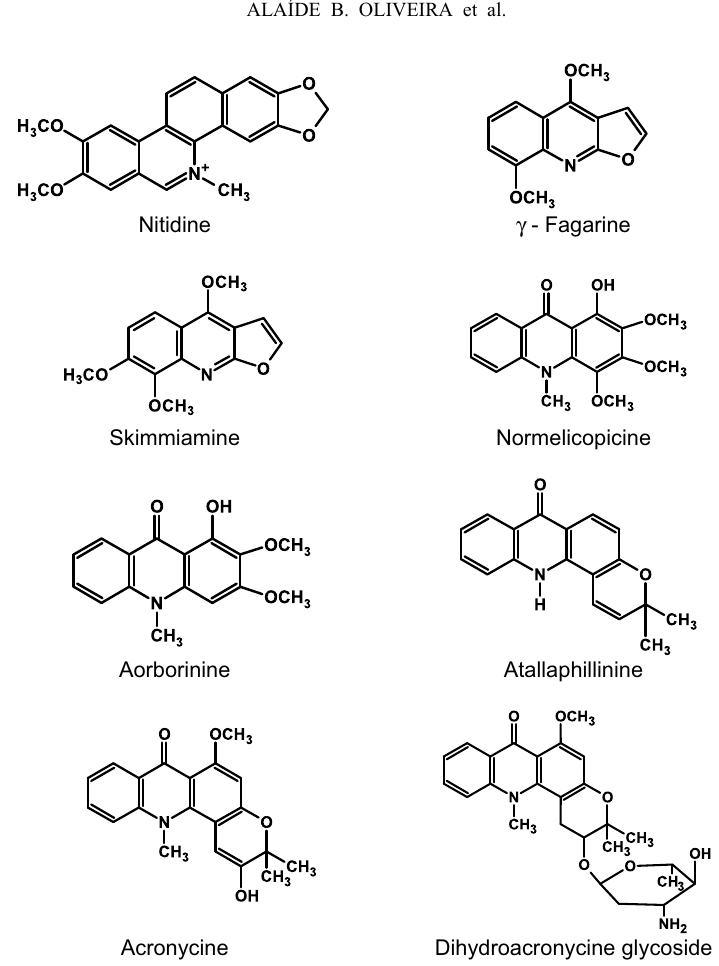
Dihydroacronycine glycoside Chart 10 – Antiplasmodial alkaloids from Rutaceous plant